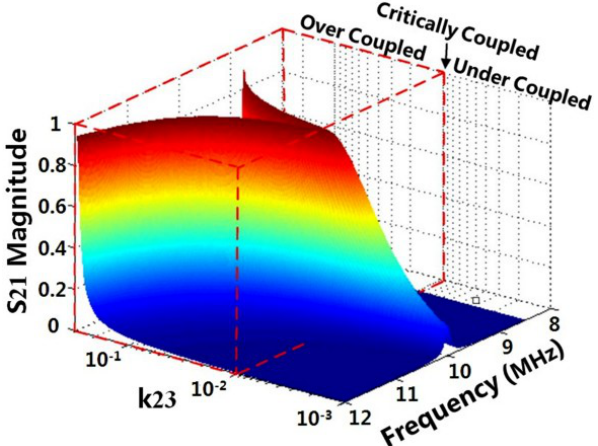
Figure 6. S magnitude as a function of frequency and coupling coefficient k 21 in the red hexahedron is called over coupled area, the remaining part is called under coupled area, and the connection between them is critically coupled